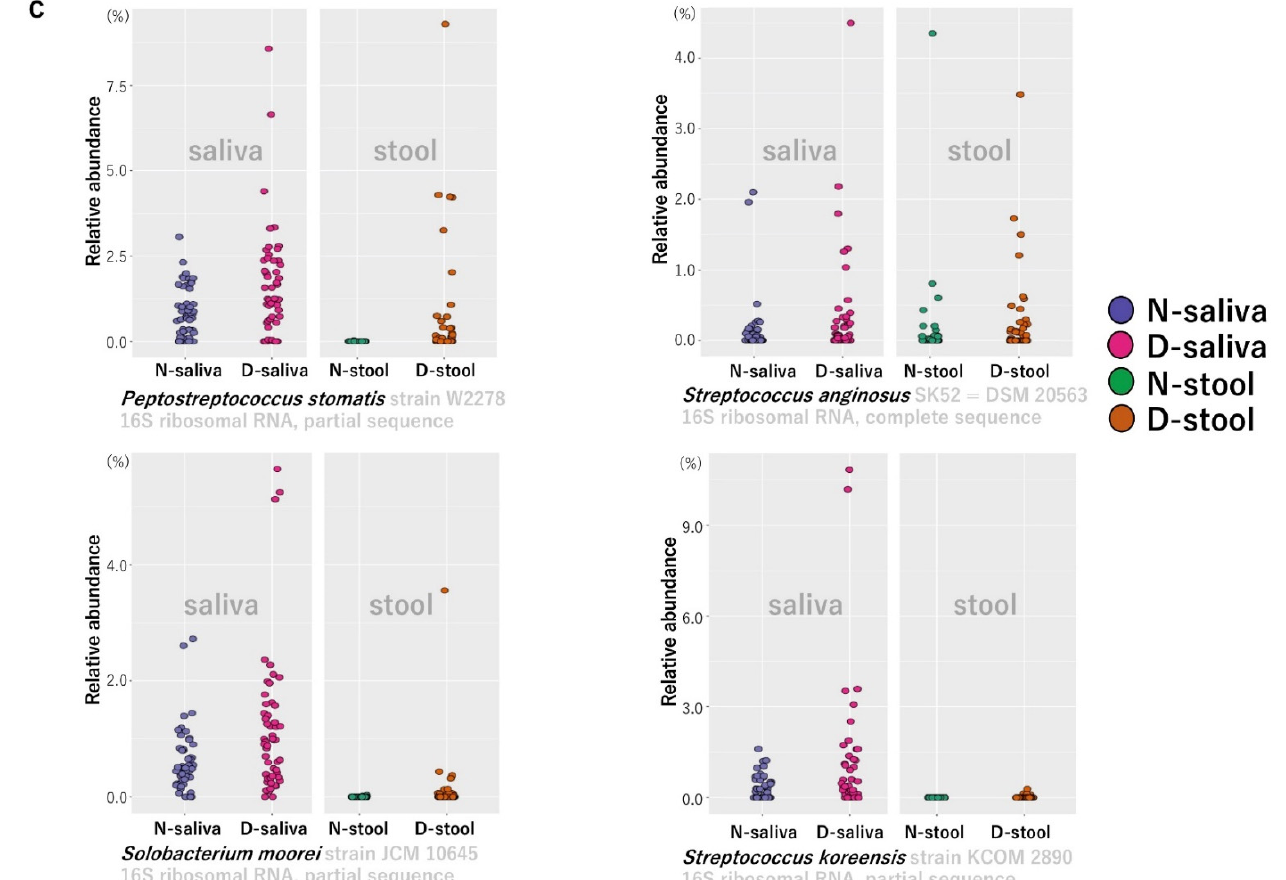
Figure 3. Linear discriminant analysis effect size (LEfSe) comparing bacterial group abundances between controls (group N) and patients with CRC (group D) in saliva ( a ) and stool ( b ) samples. ( c ) The relative abundance of four indigenous oral bacteria, Peptostreptococcus stomatis , Streptococcus anginosus , Solobacterium moorei, and Streptococcus koreensis , was statistically significant in saliva and stool of patients with CRC compared to those in controls.